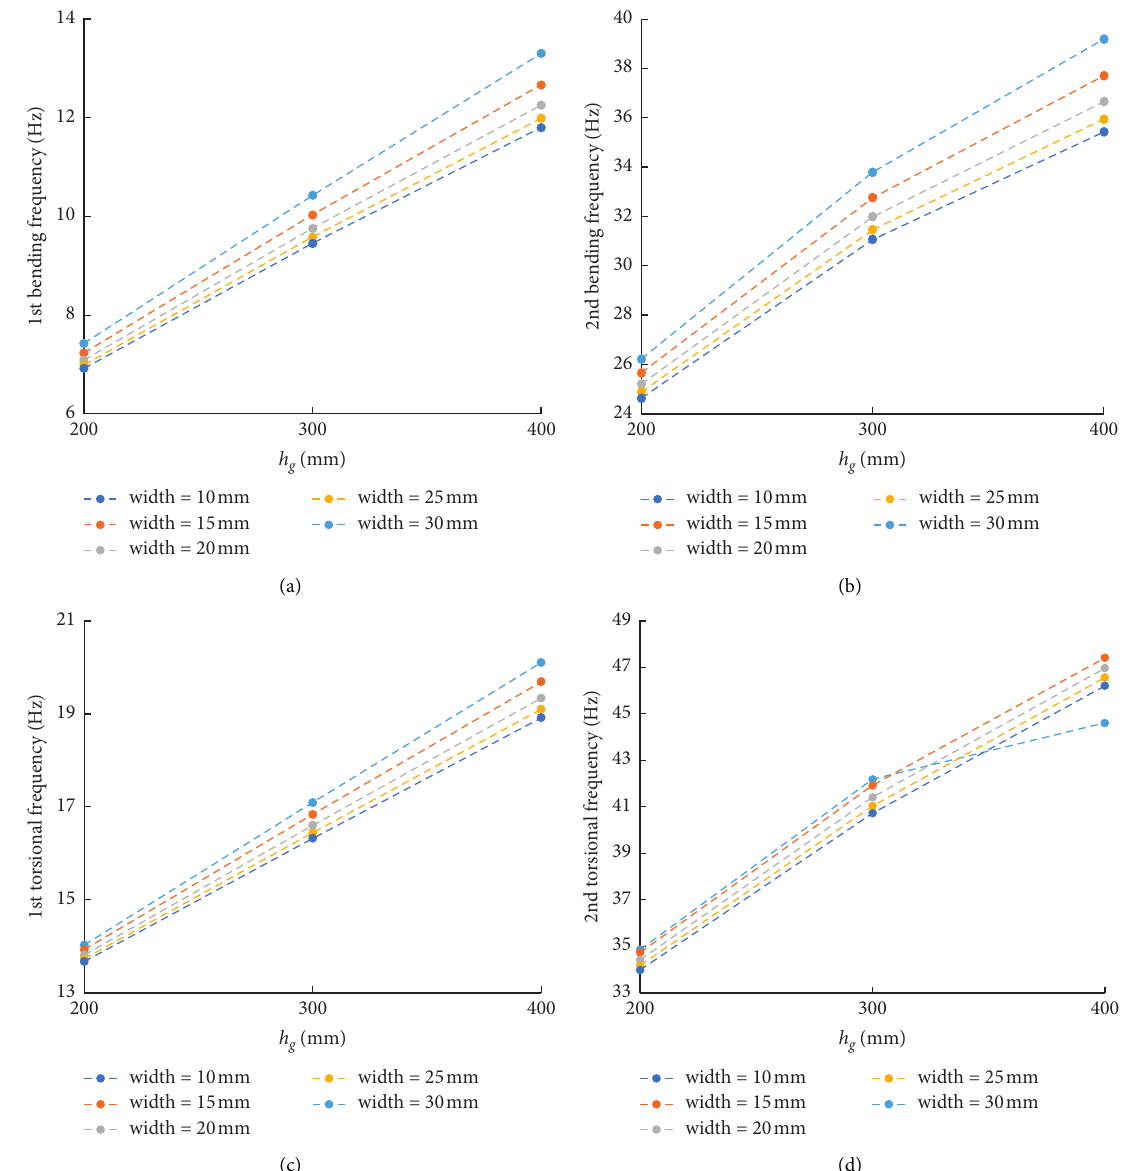
Figure 15: Natural vibration frequencies with h